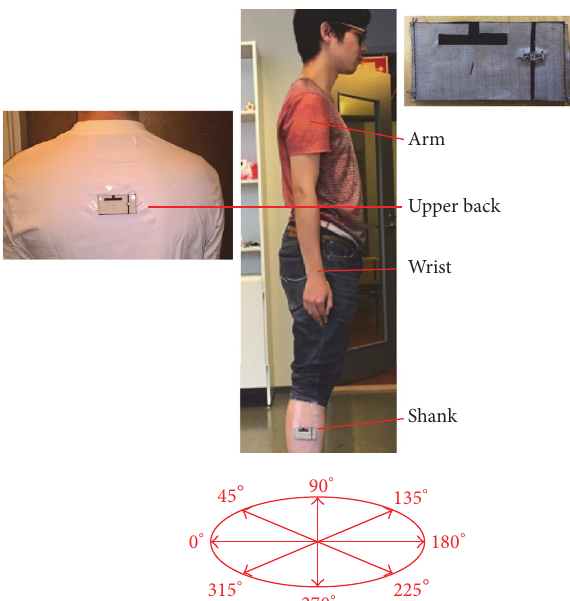
Figure 6: Measurement setup used in testing of the tags in body- worn